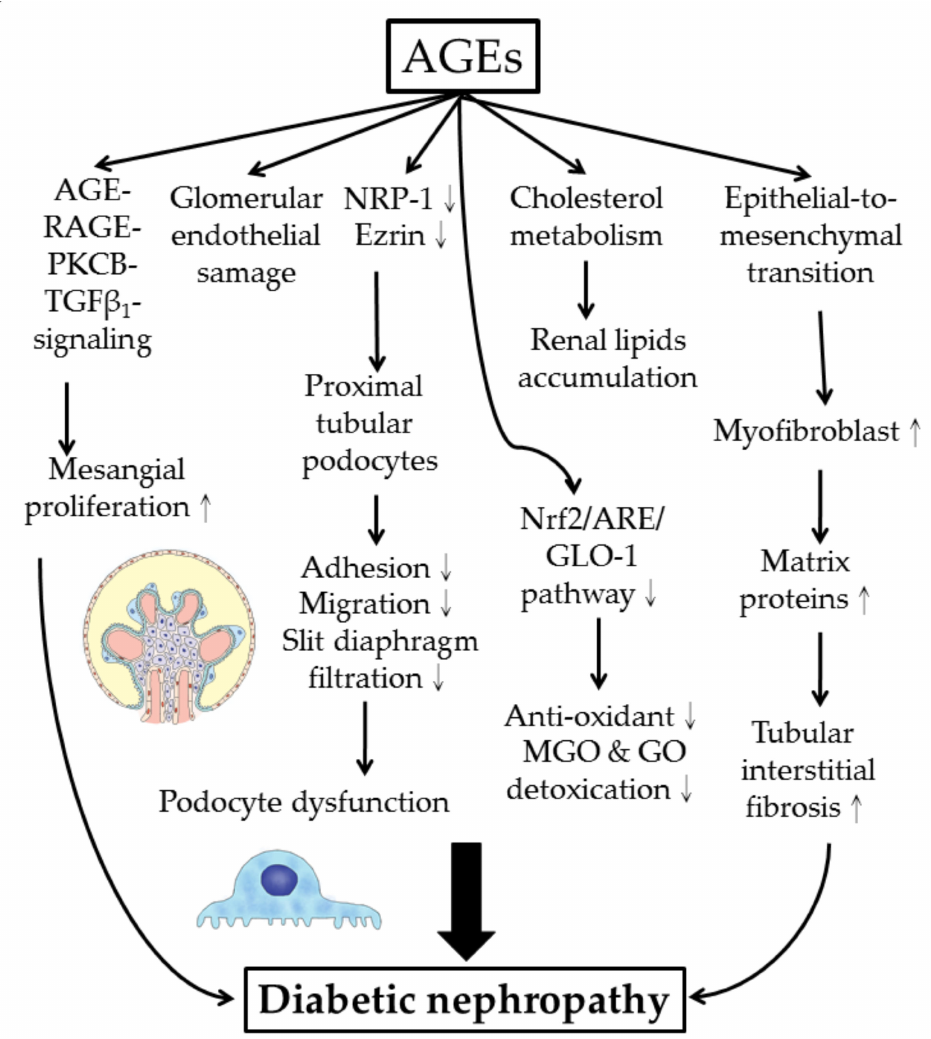
Figure 5. Cellular and molecular bases of AGE-mediated diabetic nephropathy. NRP-1: neuropilin-1; Nrf2: nuclear factor erythroid 2-related factor 2; ARE: anti-oxidant responsive element (for induction of anti-oxidant enzymes and glyoxalase 1 expression); MGO: methyglyoxal; GO: glyoxal. 5. Novel Biomolecules and Phytochemical Compounds Acting as Maillard Reaction Inhibitors, Preformed AGE Breakers, and AGE–RAGE Signaling-Pathway Blockers